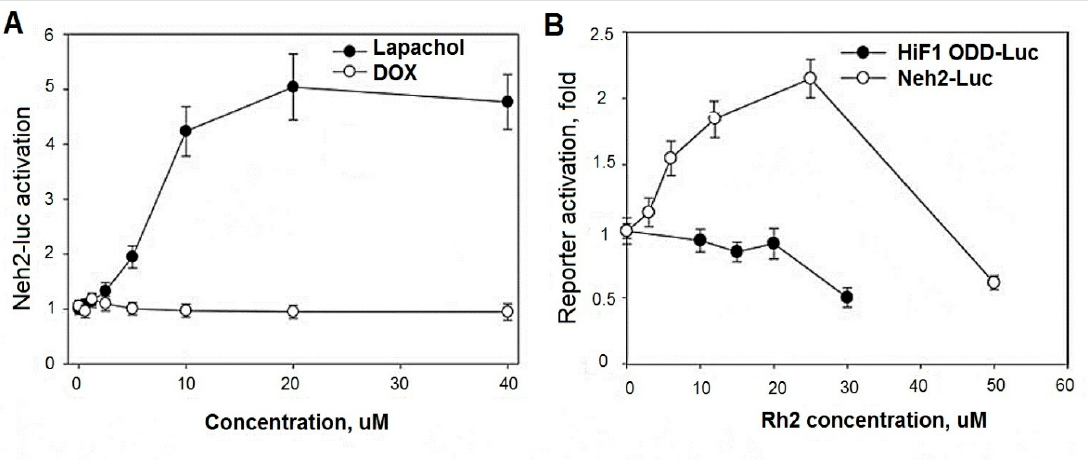
Figure 7. Rh2 as an activator of Neh2-luc reporter. ( A ). Dox does not activate Neh2-luc reporter whereas a well-known ROS producer, beta-lapachone does. ( B ). Rh2 activates Neh2-luc but not HIF1 ODD-luc reporter (3 h incubation). Results shown as mean ± SD ( n = 3).